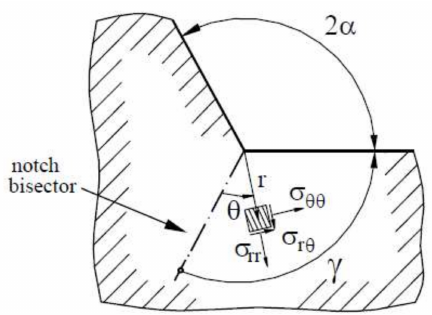
Figure 5. Polar coordinate system centred at the notch tip. Reproduced with permission from [58], Springer,